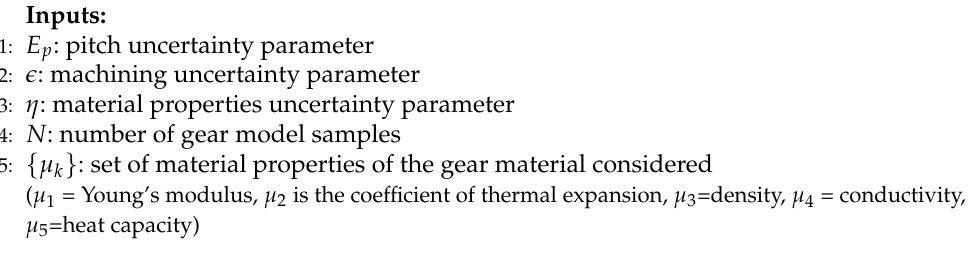
Algorithm 1 Gear model sampling with